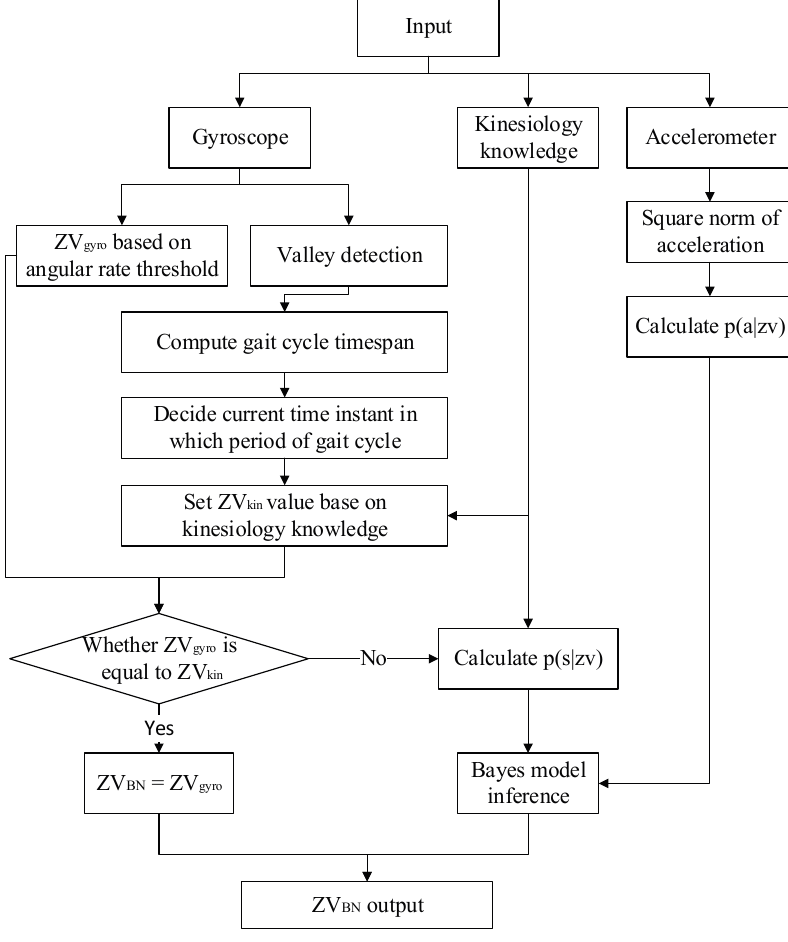
Figure 5. BN inference flow